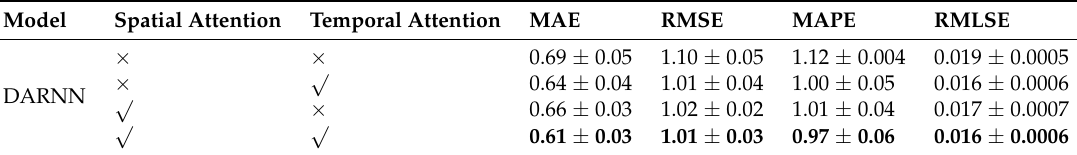
Table 7. Time series prediction results of no attention, the spatial attention, the temporal attention, and dual stage attention (best performance displayed in boldface).The size of encoder hidden states m and decoder hidden states p are set as m = p =